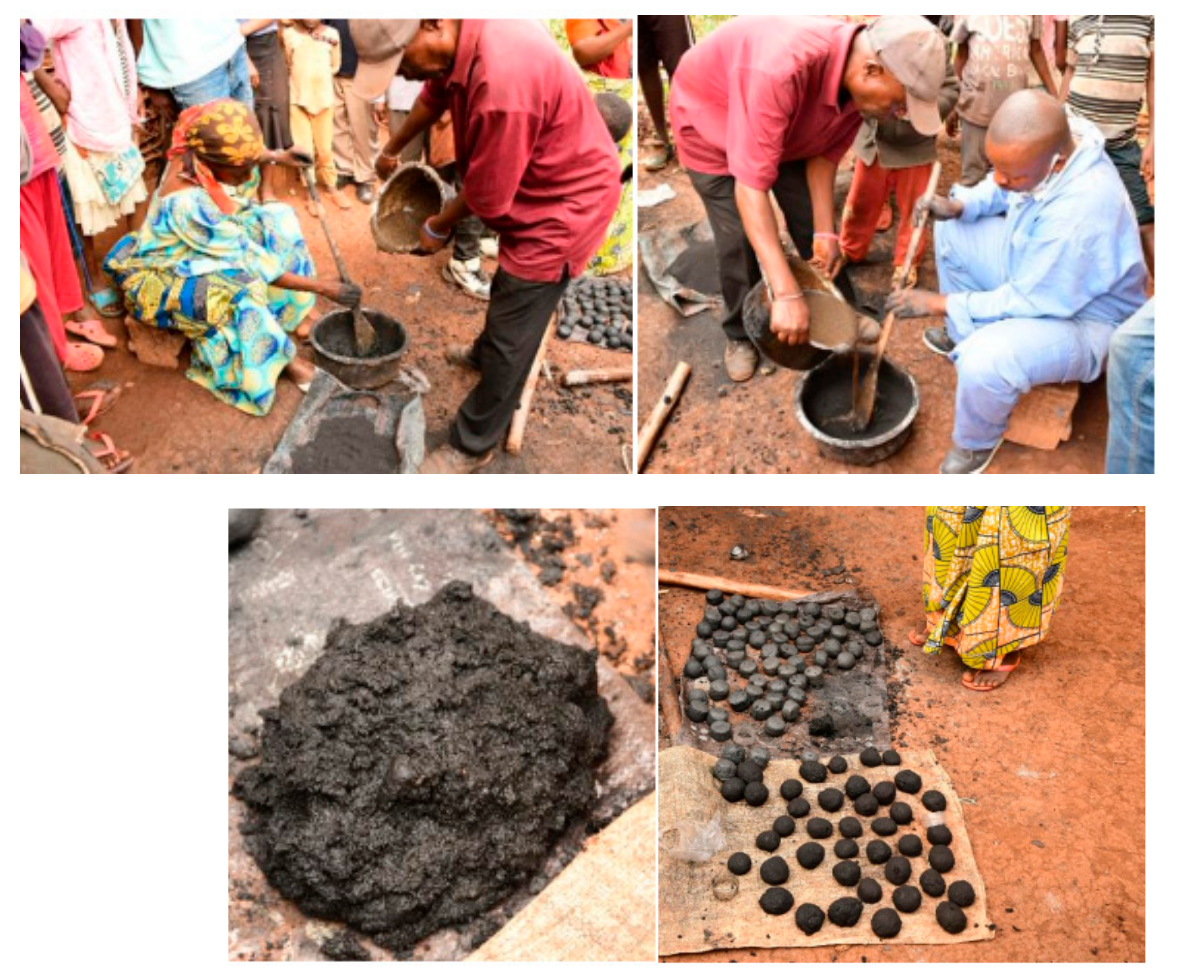
Figure 5. Steps in making briquettes by smallholder farmers supported by a local non-governmental organization, DIOBASS, in eastern DRC.